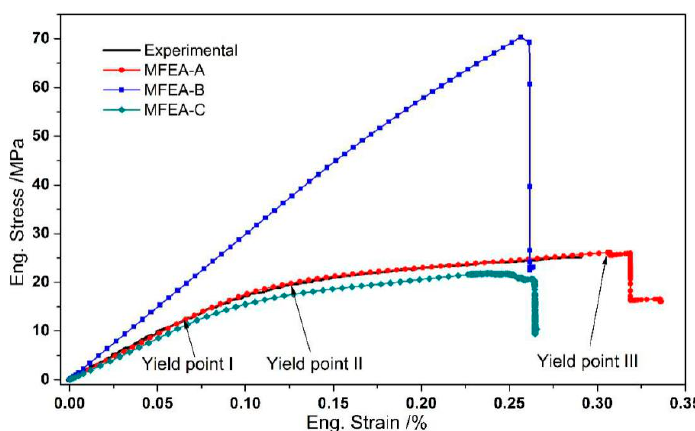
Figure 6. Experimental and calculated tensile stress ‒ strain curves of the CF/Al composites.